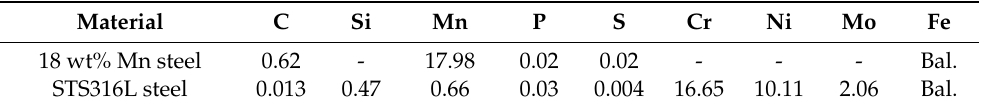
Table 1. Chemical compositions of supplied steels (in wt%).